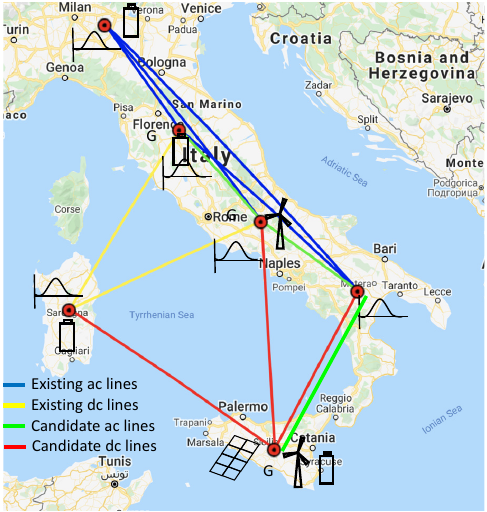
Figure 14. Italian test system used for proof-of-concept validation.